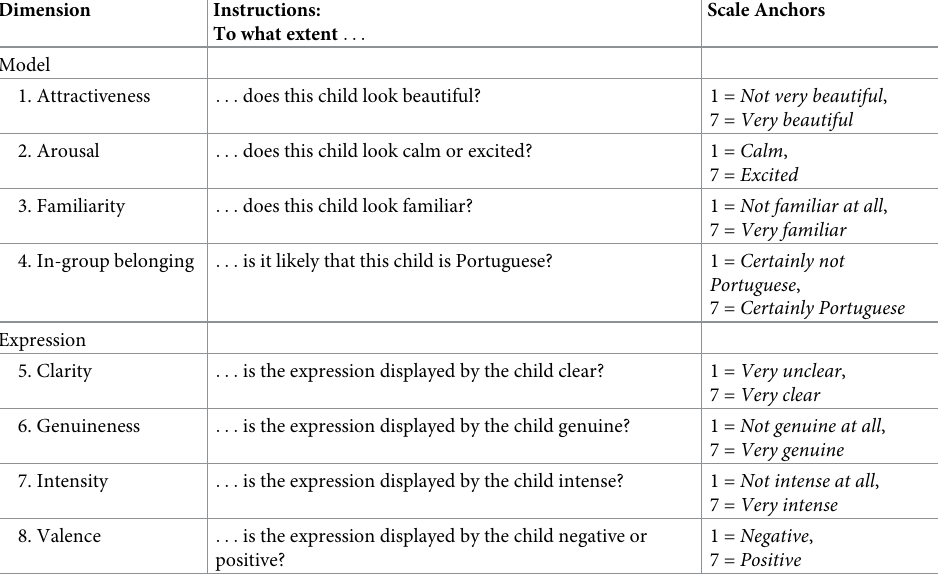
Table 3. Item wording and scale anchors for each dimension. Dimension Instructions: To what extent